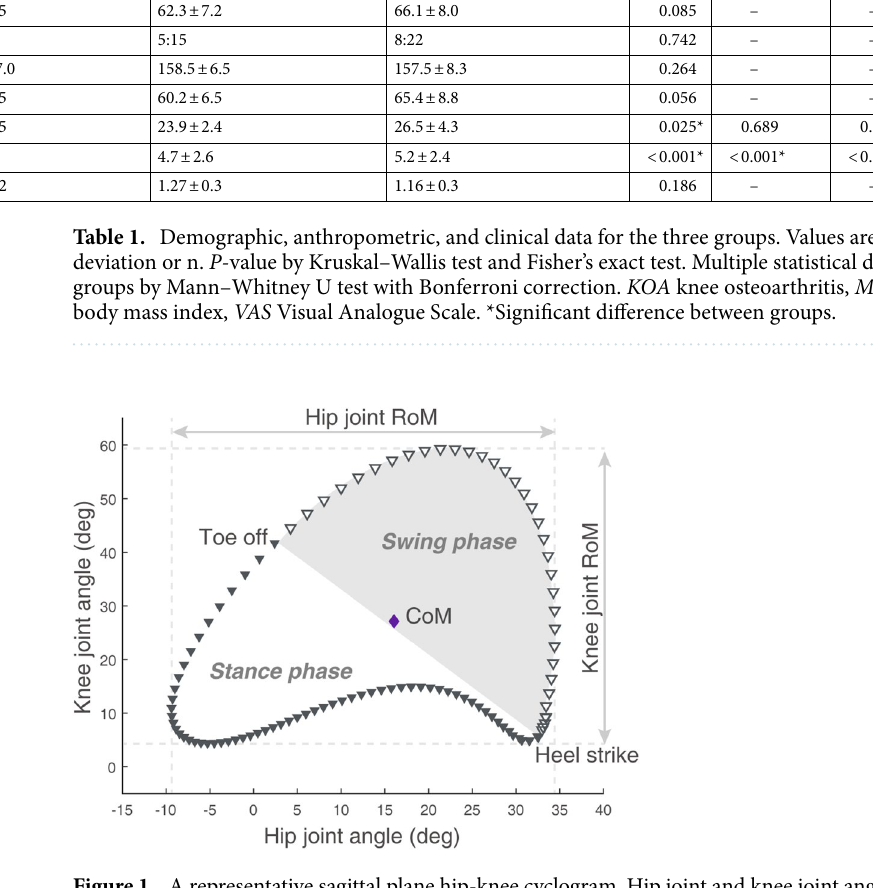
Figure 1. A representative sagittal plane hip-knee cyclogram. Hip joint and knee joint angles (degree) during the gait cycle are plotted in the clockwise direction on X-axis and Y-axis, respectively. Gait cycle is divided into stance phase (shown as filled inverted triangle) and swing phase (shown as open inverted triangle). RoM range of motion, CoM center of